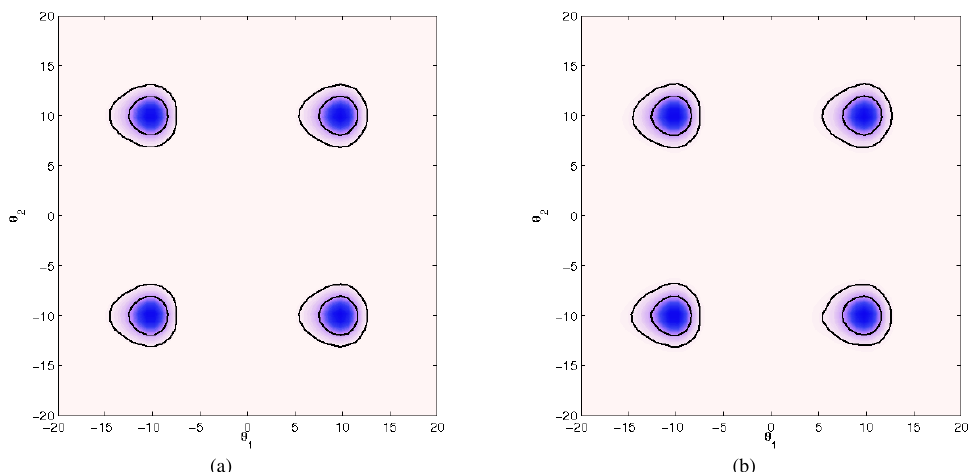
F IG . 6.— Test problem 4: Marginalized posterior distribution in the first 2 dimensions of the 20D Gaussian-LogGamma mixture model discussed in Sec. 5.4. Panel (a) shows the analytical distribution while panel (b) shows the distribution obtained from M ULTI N EST . The contours represent the 68% and 95% Bayesian credible